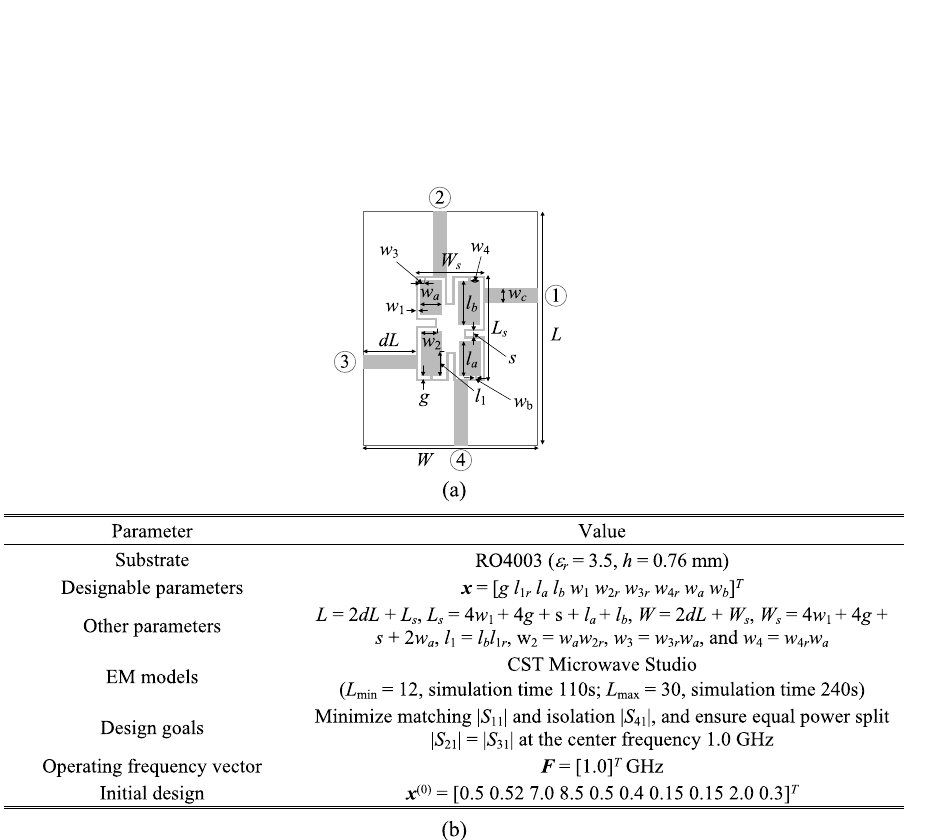
Figure 6. Compact branch-line coupler (Circuit I): ( a ) geometry 81 ; ( b ) main parameters and design